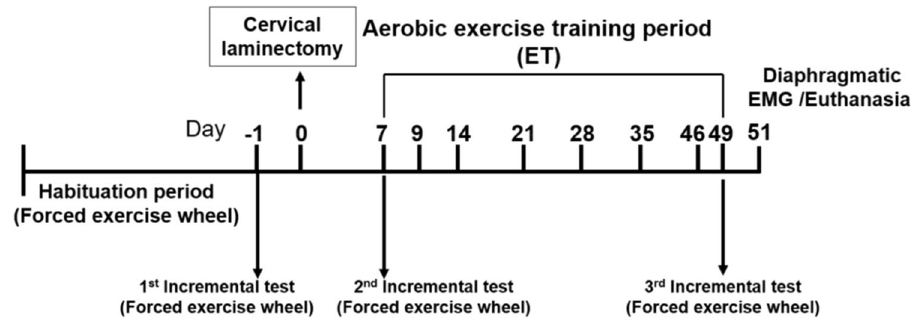
Figure 10. Experimental design throughout surgery and low intensity exercise training periods. After 1st incremental test on forced exercise wheel, animals were distributed into six experimental groups (3 sedentary and 3 trained of NAIVE, SHAM and SCI). SHAM and SCI groups underwent cervical laminectomy followed by a 1-week recovery. Next, all groups went through a 6-week aerobic exercise training on forced exercise